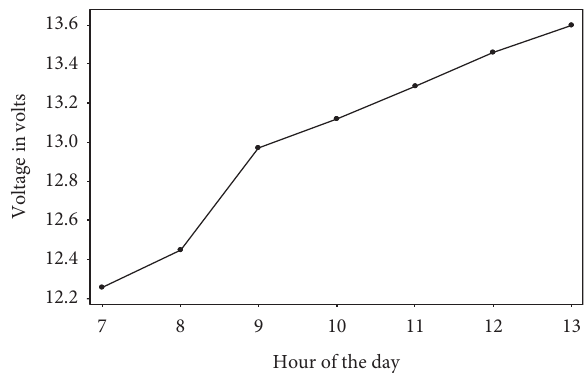
Figure 29: A lead-acid battery voltage charging curve.